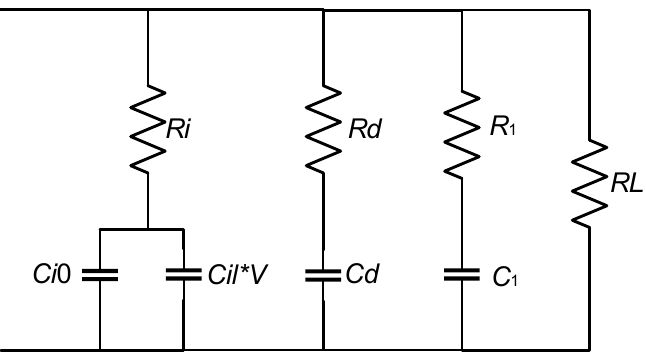
Figure 11. The Zubieta model of DLCs showing the three different RC branches.